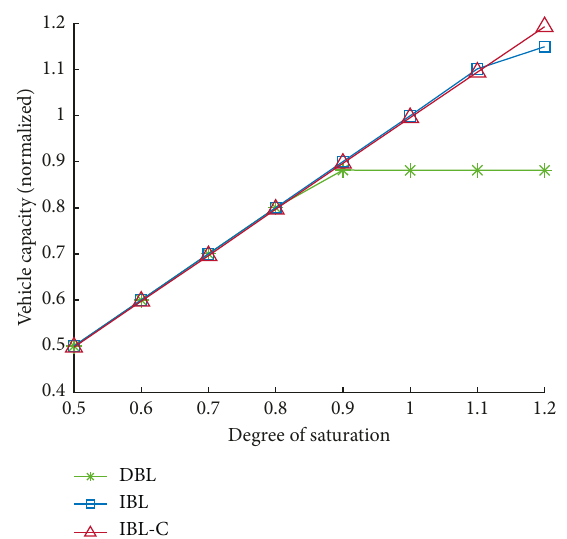
Figure 15: Average traffic flow volume with near-side stop when the interval of buses is